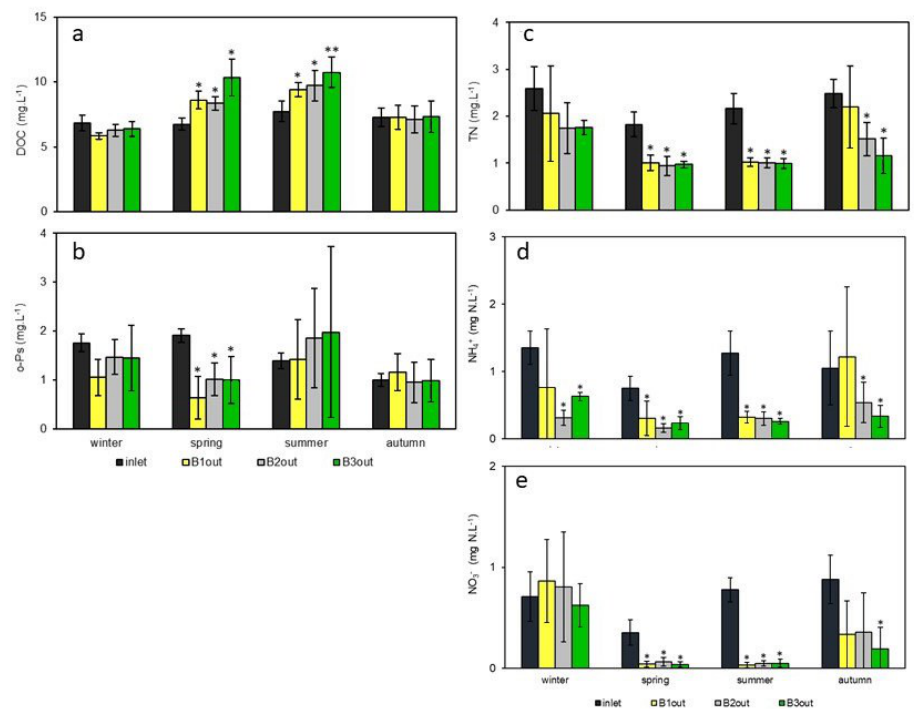
Figure 3. Variations in ( a ) DOC, ( b ) o-Ps, ( c ) TN, ( d ) ammonium and ( e ) nitrates according to the seasons for the inlet and the three outlets (B1out, B2out and B3out). * indicates a significant difference (Student’s t -test) between the seasons (* p < 0.05, ** p < 0.01). The sample size ( n ) varies seasonally for the inlet (winter: n (8); spring: n (11); summer: n (22); autumn: n (17)) and outlets (winter: n (3); spring: n (4); summer: (8); autumn: n (7)).